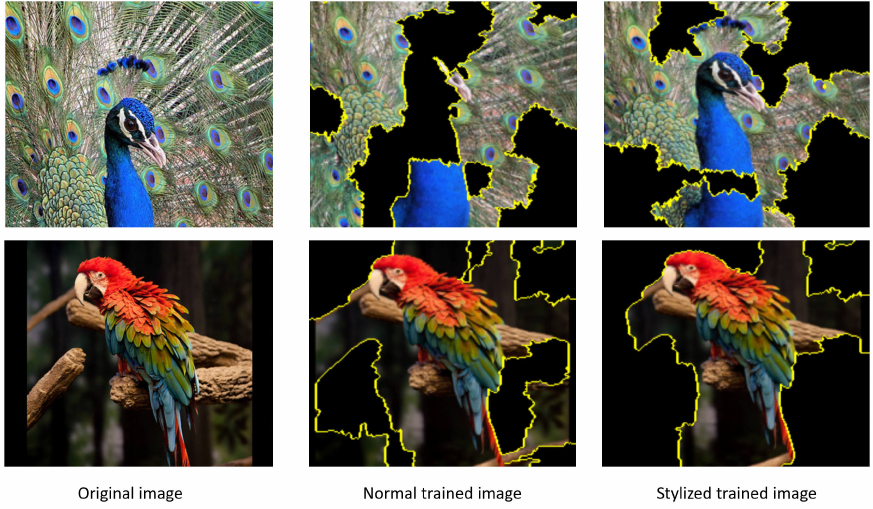
Figure 6. Explaining image classification prediction made by models with stylized pairing training and normal training.